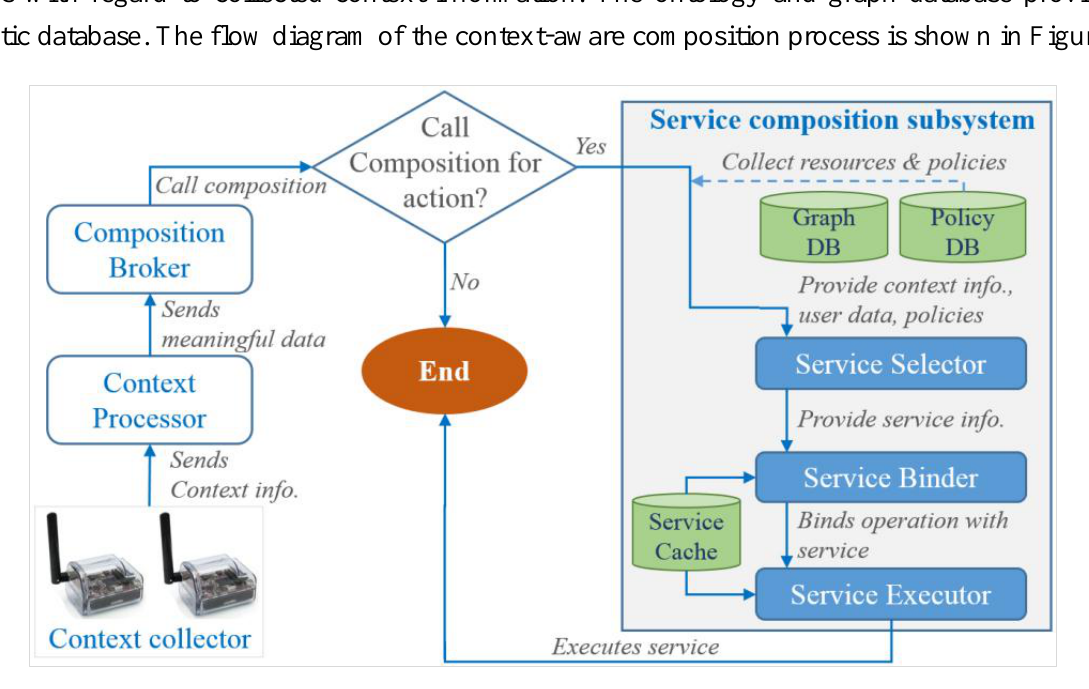
Figure 10. Composition process based on context information provides efficient and accurate service